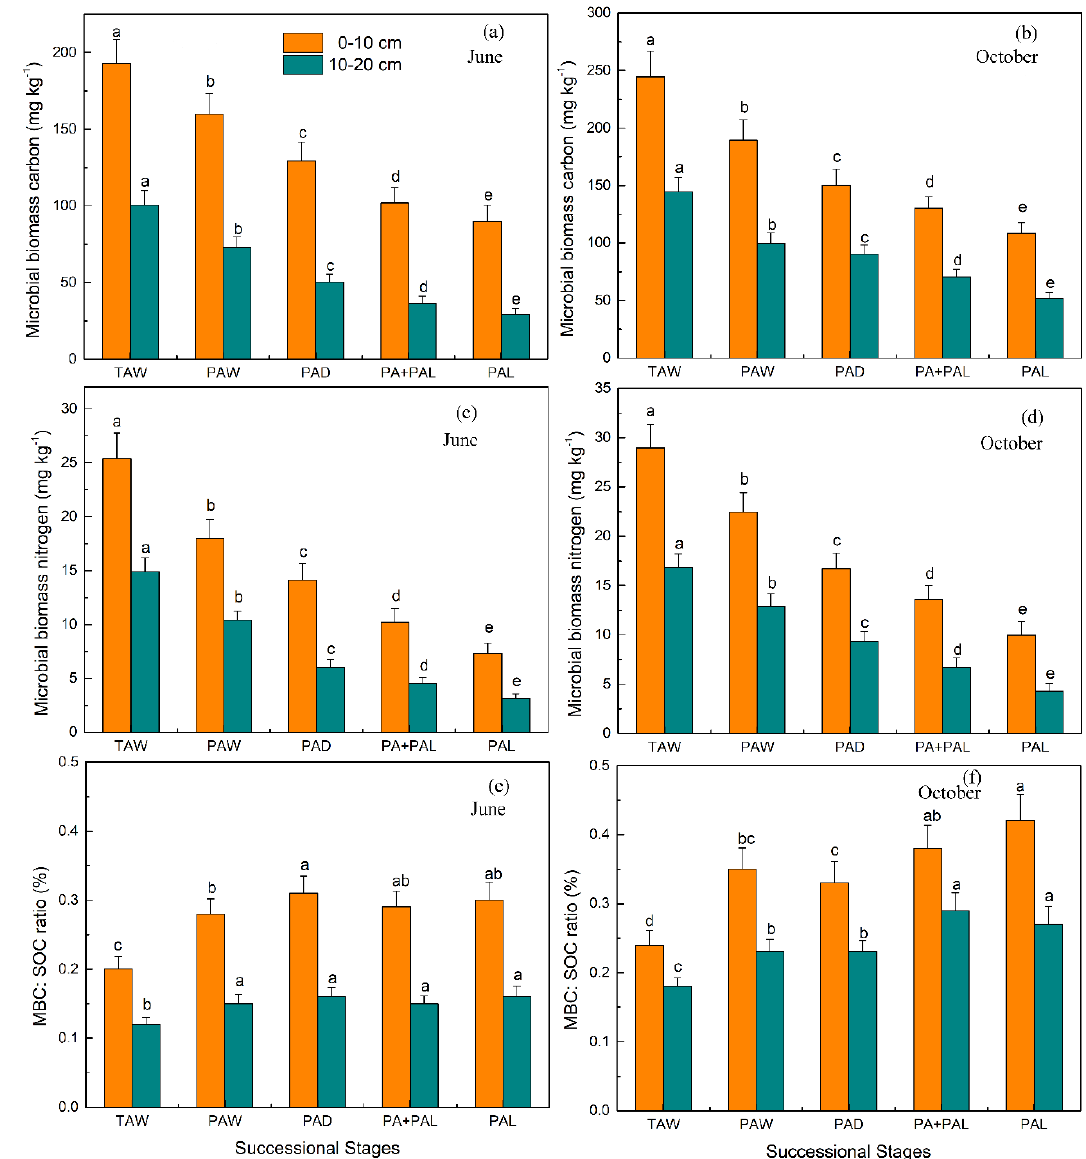
Figure 2. Microbial biomass and microbial quotient (MBC:SOC ratio) in the wetland drying process in June ( a , c , e ) and October ( b , d , f ). Values are Mean ± SE ( n = 9). Different letters over the bars indicate statistically significant differences between different stages. TAW, T. augustifolia wetland; PAW, P. australis wetland; PAD, P. australis dry land; PA + PAL, mixed grassland with P. australis and P. arundinacea L.; PAL, P. arundinacea L. grassland.